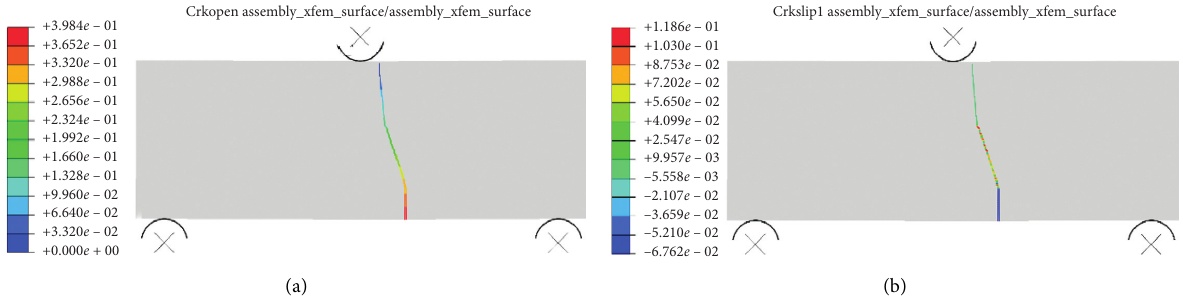
Figure 7: The displacements of the final crack: (a) opening displacement; (b) slipping displacement.